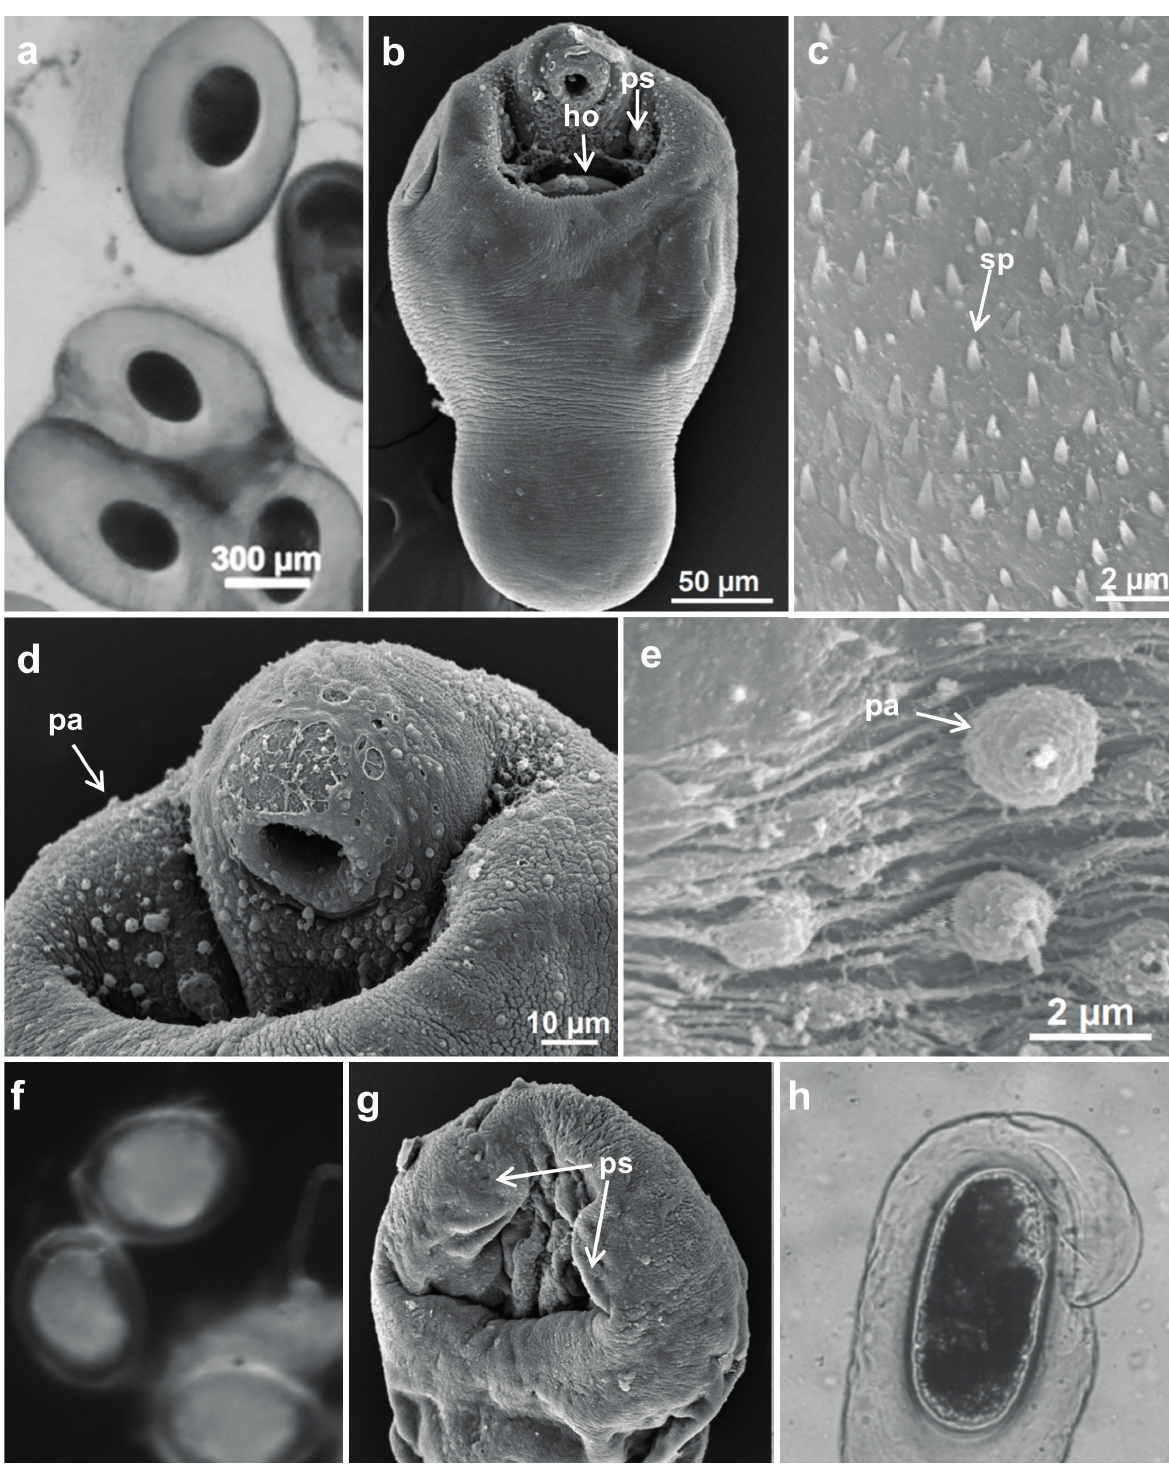
Figure 2 - Strigea sp. 1. ( a ) cysts; ( b ) whole-mount, ventral view; ( c ) tegumental spines of holdfast organ; ( d ) cephalic end, ventrolateral view; ( e ) cephalic region (note ciliated papillae). Strigea sp. 2. ( f ) cysts; ( g ) whole-mount, ventrolateral view. Strigea sp. 3. ( h ) cyst. Abbreviations: pa, papillae; ho, holdfast organ; ps, pseudosuckers; sp,